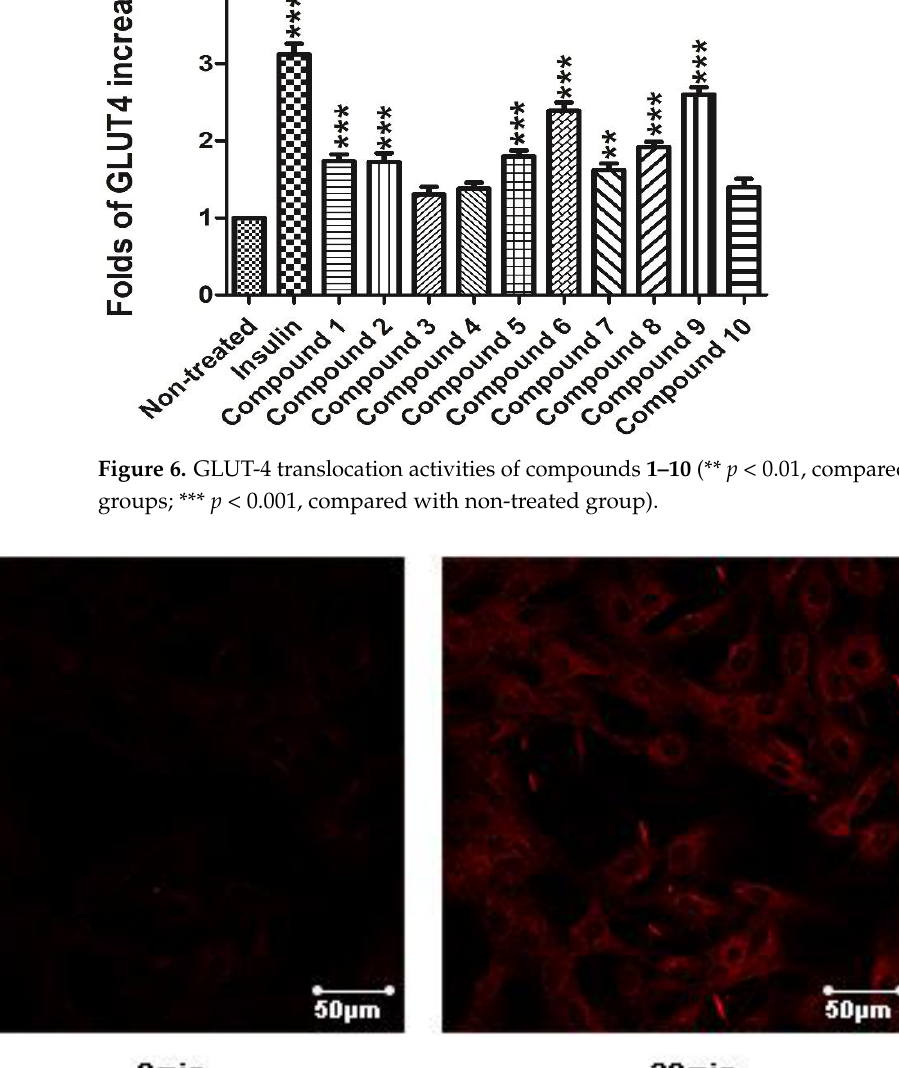
Figure 7. Effects of compound 9 on stimulating GLUT-4 translocation in L6 cells.